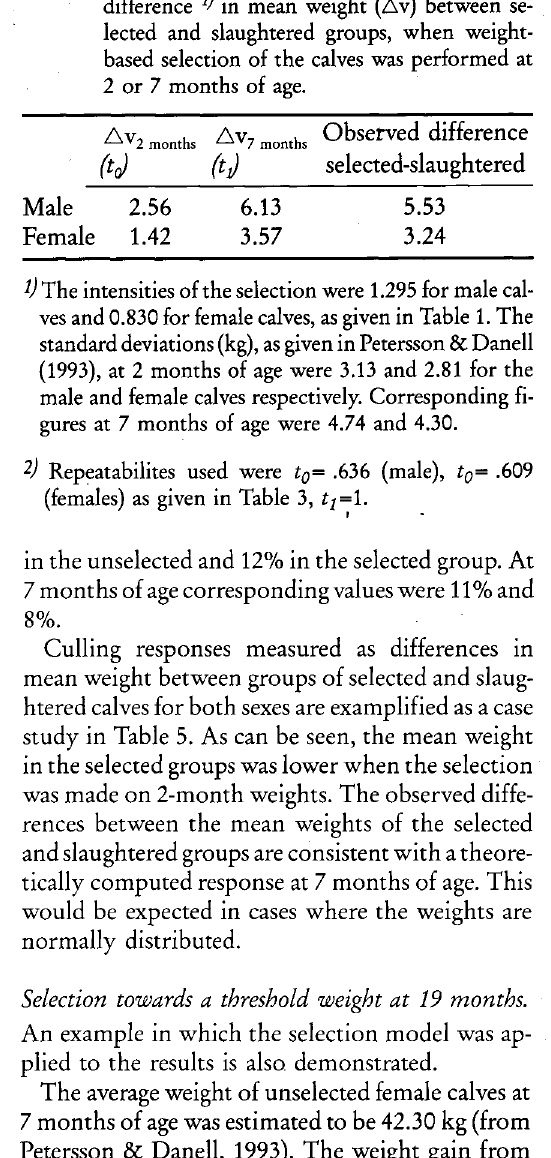
Table 5. Example of expected response, measured as the difference ^ in mean weight (Av) between se lected and slaughtered groups, when